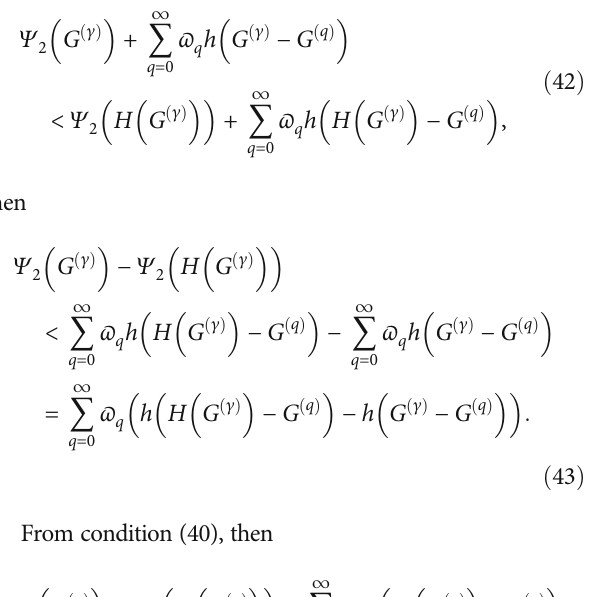
map on the q -dimensional Hilbert space ℓ q